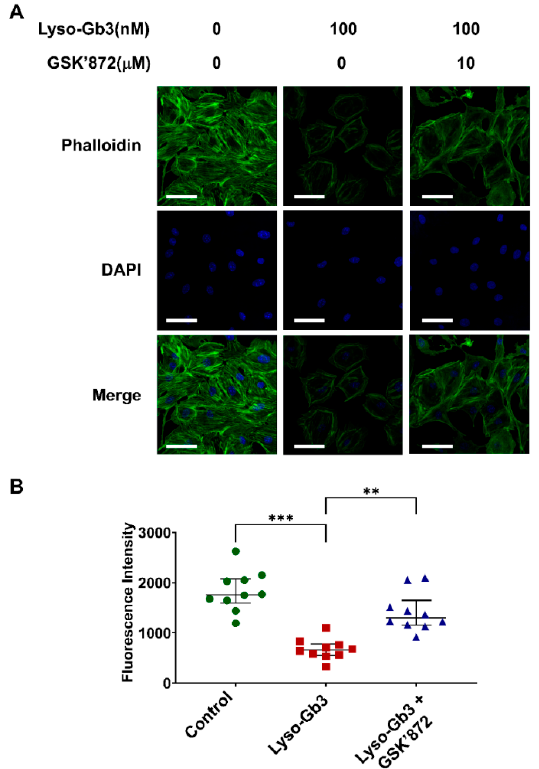
Figure 3. Cytoskeleton rearrangement induced by lyso-Gb3. Mouse podocytes grown on coverslips were treated with lyso-Gb3 with or without GSK’872 treatment. The cells were fixed with 4% PFA and immunolabeled with FITC-phalloidin (green) and DAPI (blue). ( A ) Representative morphologic changes in the actin cytoskeleton. Podocytes treated with lyso-Gb3 show in peripheral rearrangement of actin stained with phalloidin. The cytoskeleton arrangement was attenuated by GSK’872 treatment. Magnification, 40×; bar = 50 μ m. ( B ) Quantitative analysis of fluorescence intensity of actin cytoskeleton rearrangement. The decreased fluorescence intensity in lyso-Gb3 treated podocytes was recovered by GSK’872 treatment ( N = 10, median with interquartile range). ** p < 0.01, *** p < 0.001 by Kruskal-Wallis with Dunn’s post-hoc analysis.